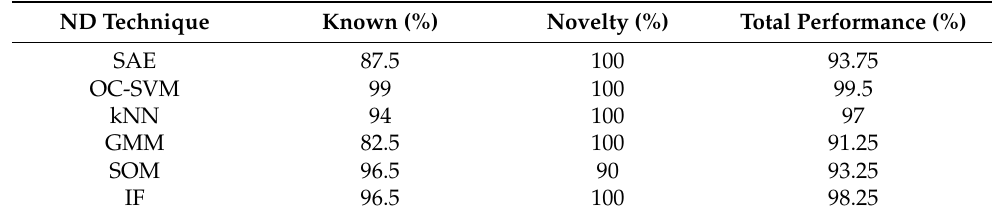
Table 9. Numerical results of the novelty detection obtained for the fifth case study of the SPG_DS.